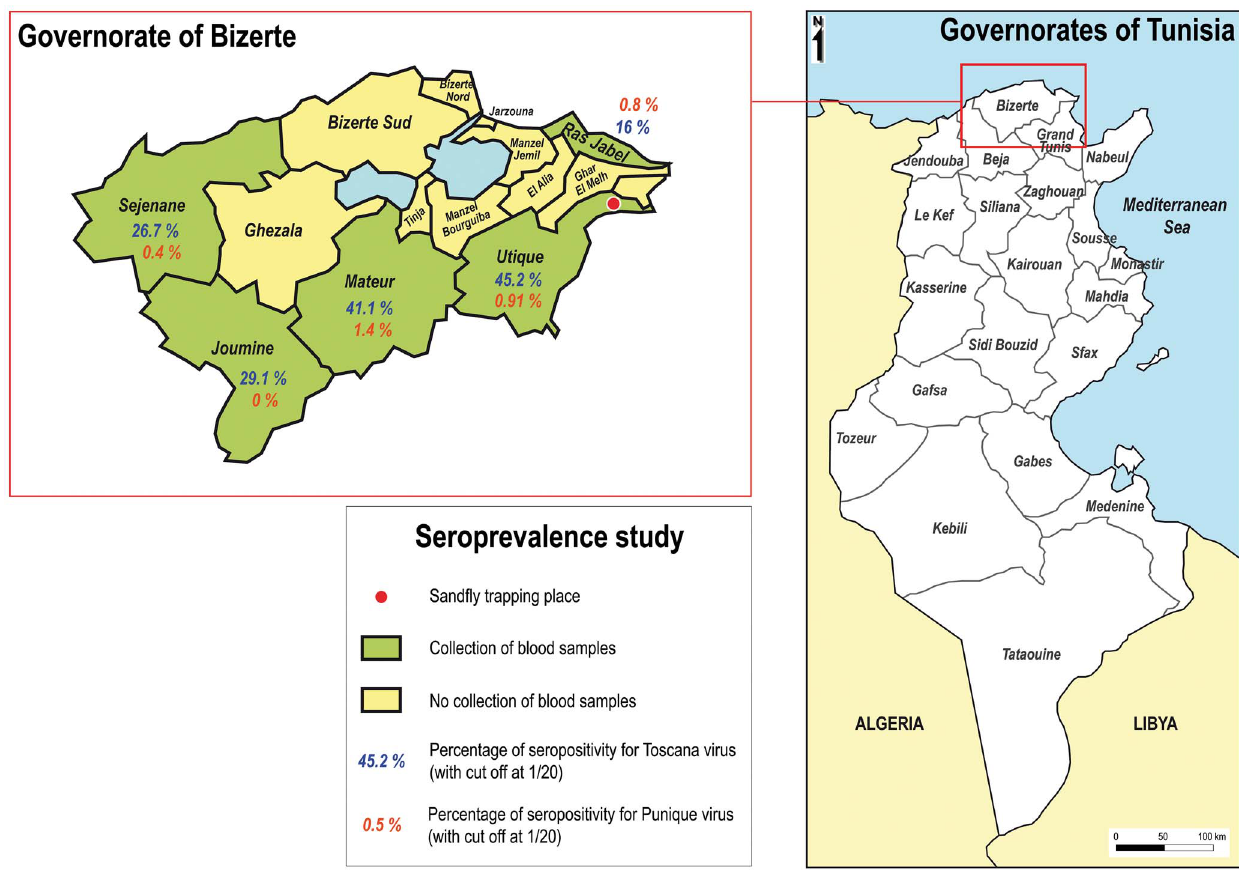
Figure 1. Regions investigated for the seroprevalence study.